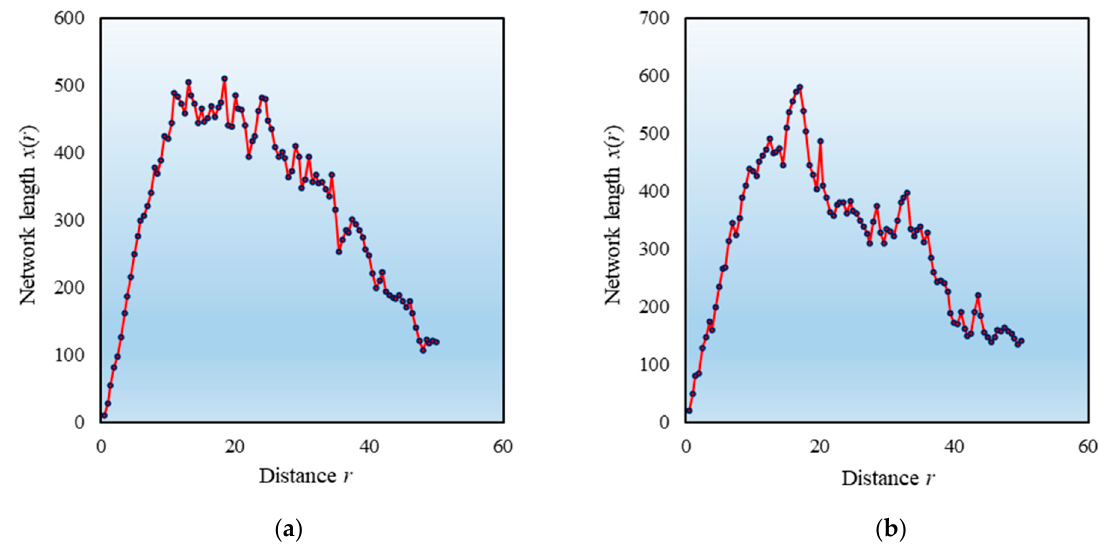
Figure 3. The spatial signals for traffic network of Beijing and Shanghai cities (2016). ( a ) Beijing; ( b ) Shanghai. Note: These spatial signals represent urban traffic lines extracted through concentric circles and Equation (13). Each value reflects a total length of streets and roads falling in two adjacent circles.